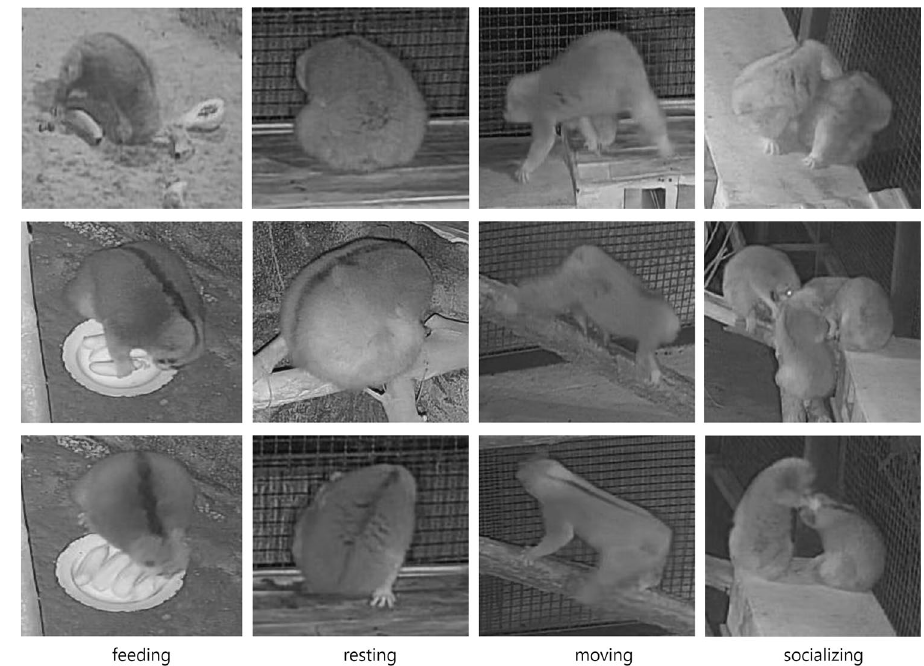
Figure 2. The images of postural behavior extracted by